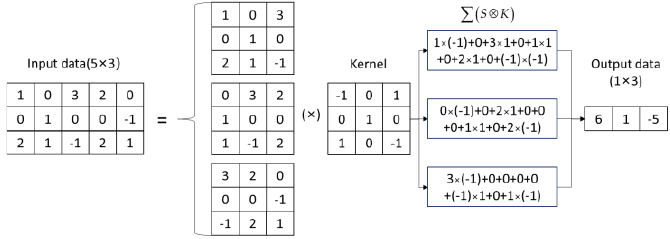
Figure 3. One-dimensional convolutional process.